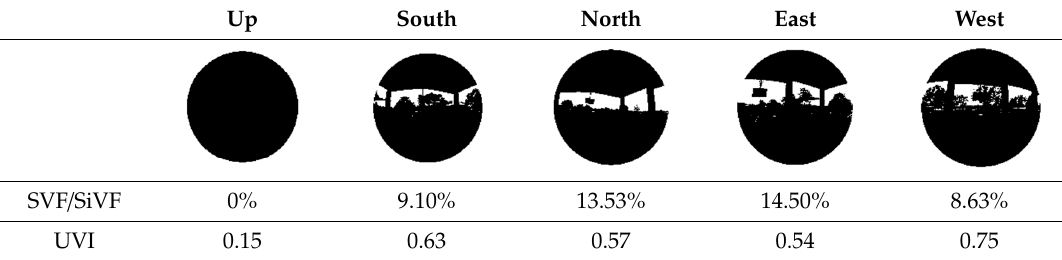
Figure 3. ( a ) Correlation between UVRab and UVRint for children, ( b ) UVRab and UVRint for adults. The red line illustrates the linear fitted line.